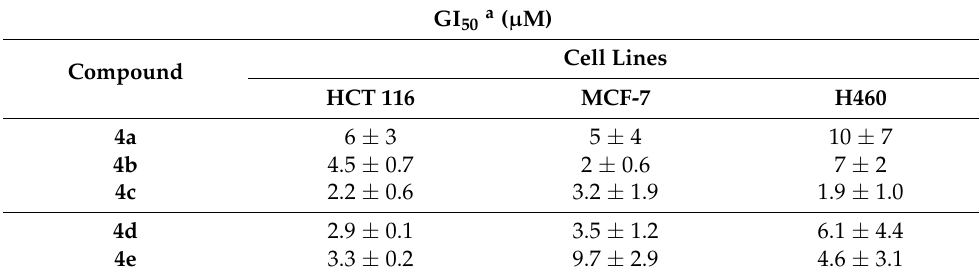
Table 3. Antiproliferative activity of 4a–4e compounds against solid tumor cell lines expressed as the GI 50 a